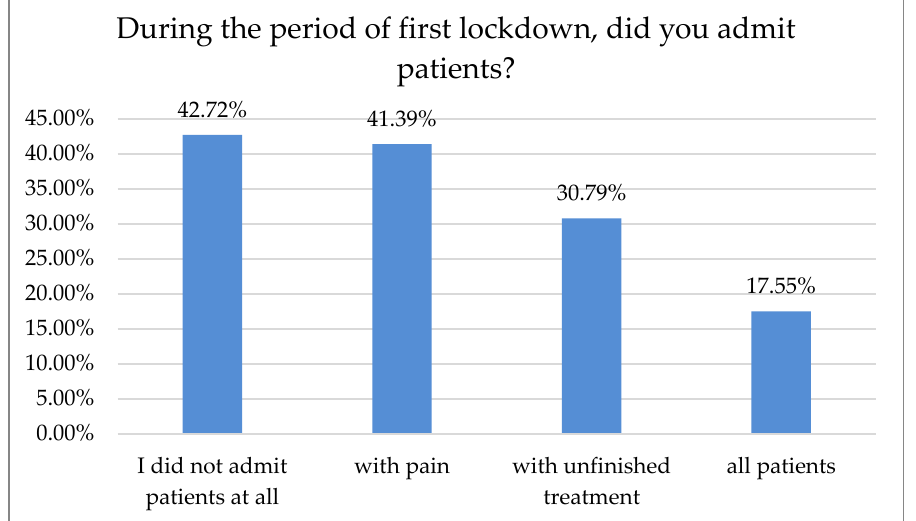
Figure 8. Changes in patients admitted during the lockdown.